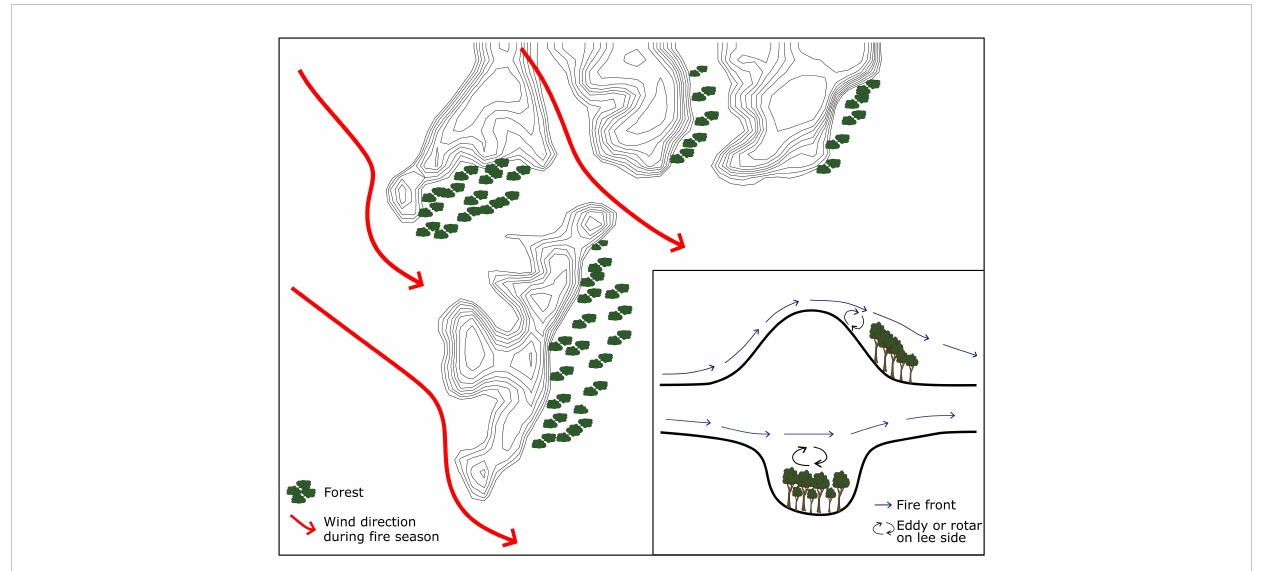
FIGURE 2 Hypothetical wind fl ow patterns, fi re spread direction, and the location of fi re refugia forests in relation to topography and dominant wind direction during the fi re season. Inset showing a schematic of air fl ow across topographic barriers indicating the development of leeward eddies and the probable locations of forests in wind shadows. Adapted from Geldenhuys